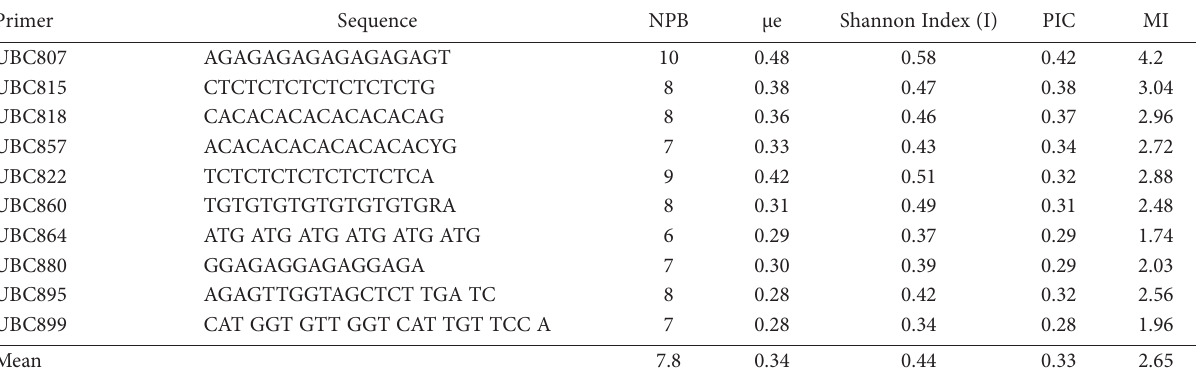
Table 2. Numbers of polymorphic bands (NPB), heterozygosity (μe), Shannon indices, polymorphism information content (PIC), and marker indices (MI) of ISSR markers used for defining genetic diversity of 75 Ascochyta rabiei isolates. Primer